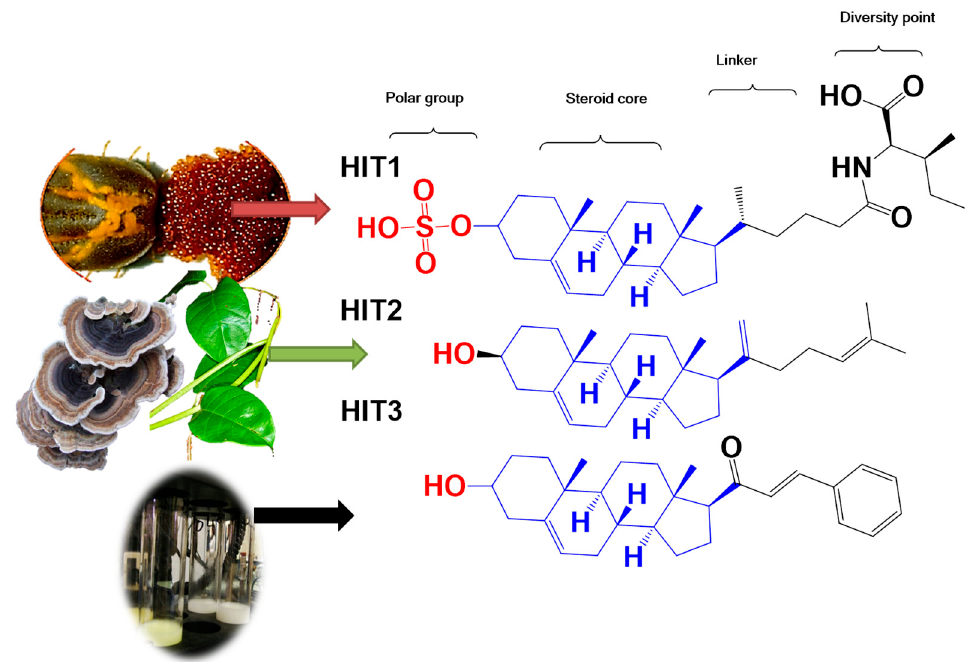
Figure 1. Boophiline ( HIT1 ) is a steroid molecule present in R. microplus eggs that protects them against microbes. A similar steroid was reported with moderate antiparasitic activity from P. andrieuxii roots and T. versicolor ( HIT2 ). In addition, HIT3 was previously reported as a simple steroid compound with diverse biological activities [18,19]. Brackets show where structural modifications were made for the design of new steroid derivatives.